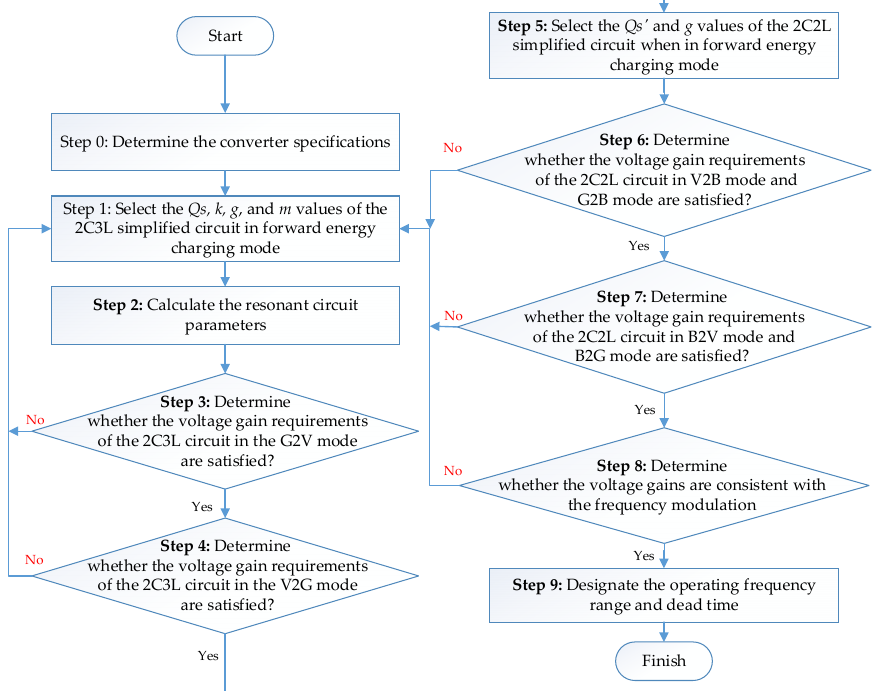
Figure 7. Isolated three-port power converter with 2C3L and 2C2L resonant circuits. Step 0: Determining the converter specifications.